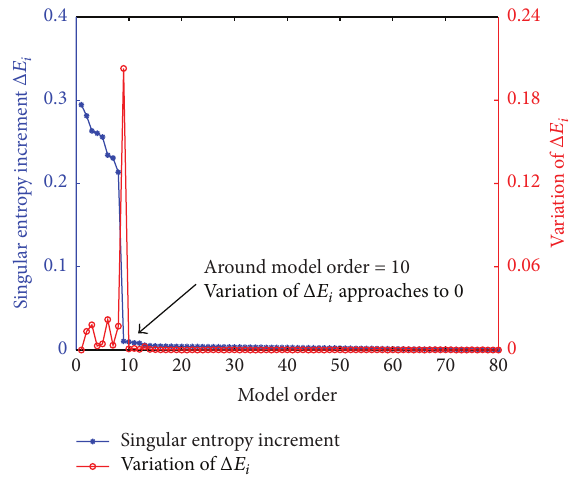
Figure 3: The frame structure: the change of singular entropy increment and its first-order variation to model